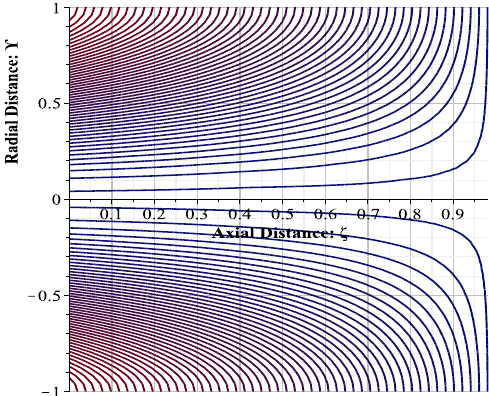
Figure 9. Stream lines for W RE = 0.9 × 10 − 5 .